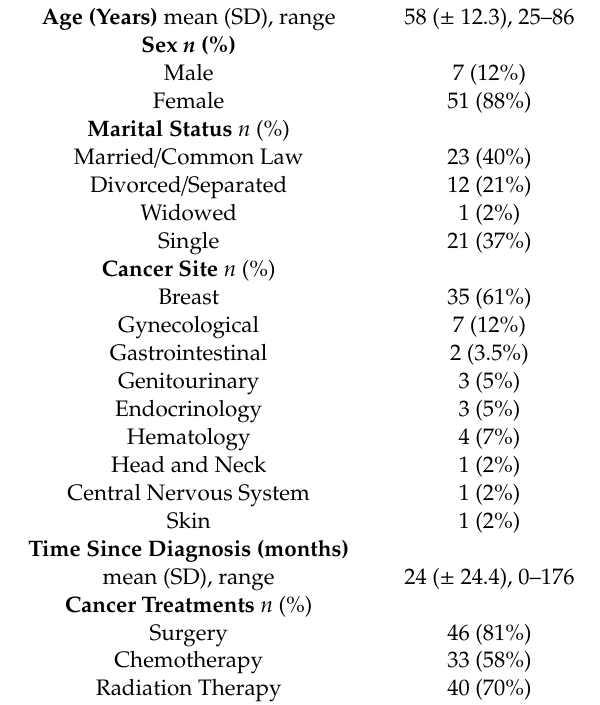
Table 1. Participant